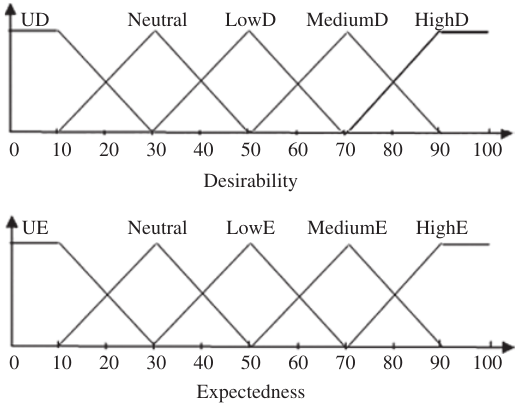
Figure 4. Membership Function of Desirability and